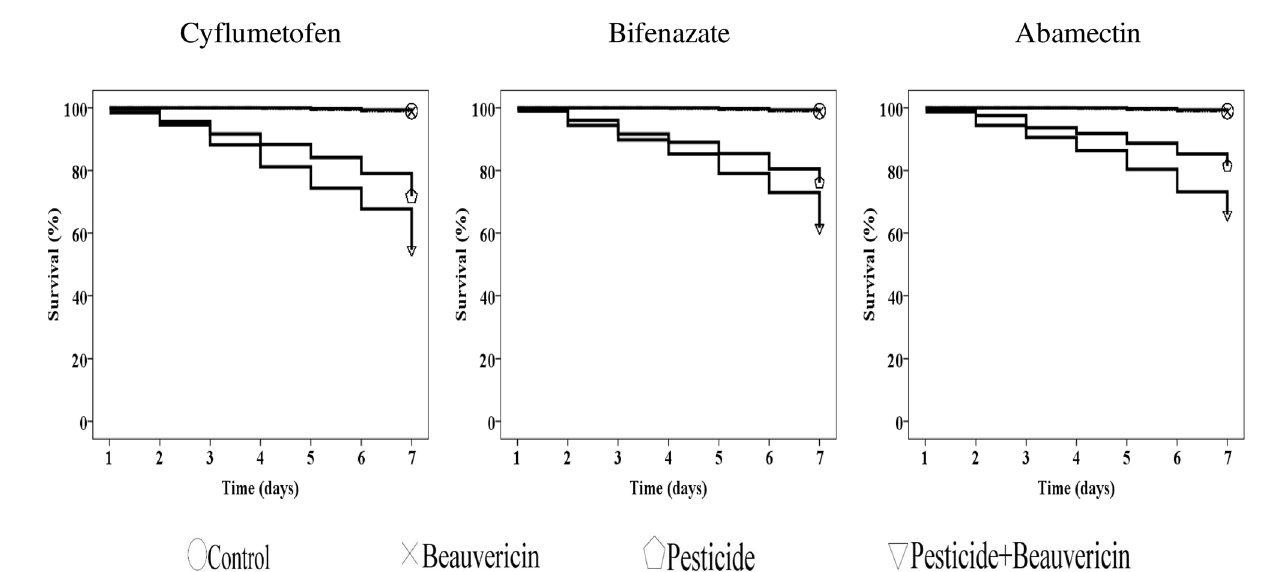
Figure 1. Curves representing survival of T. urticae exposed to pesticide molecules (cyflumetofen, bifenazate, or abamectin) alone and in combination with